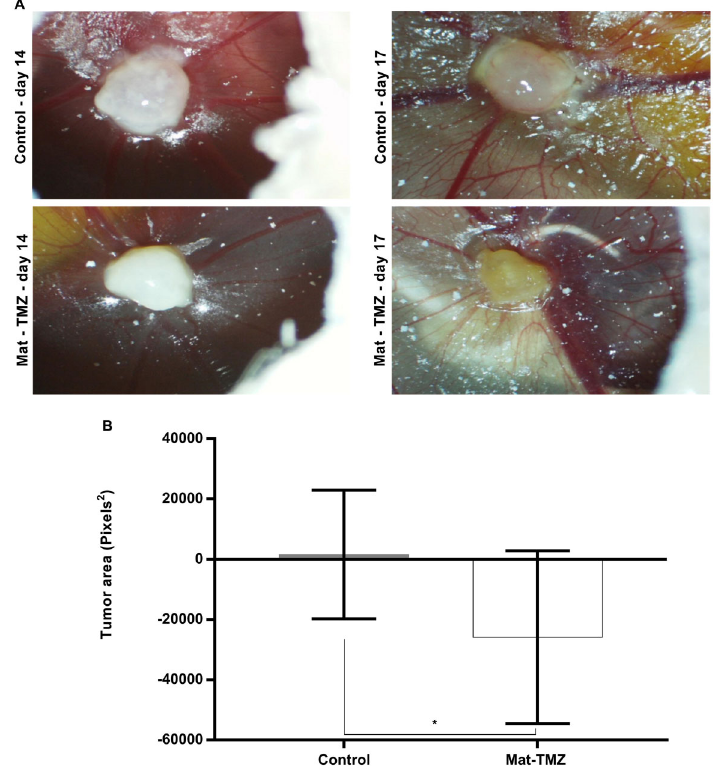
Figure 7. Change in tumor area in vivo in the chorioallantoic membrane assay after treatment with matteucinol-temozolomide (Mat- TMZ). A , Representative images of the control and treated group on the 14th and 17th days. B , Tumor area was measured in square pixels. Data are reported as mean percent tumor growth ± SD. *P=0.0238 (Student ’ s t